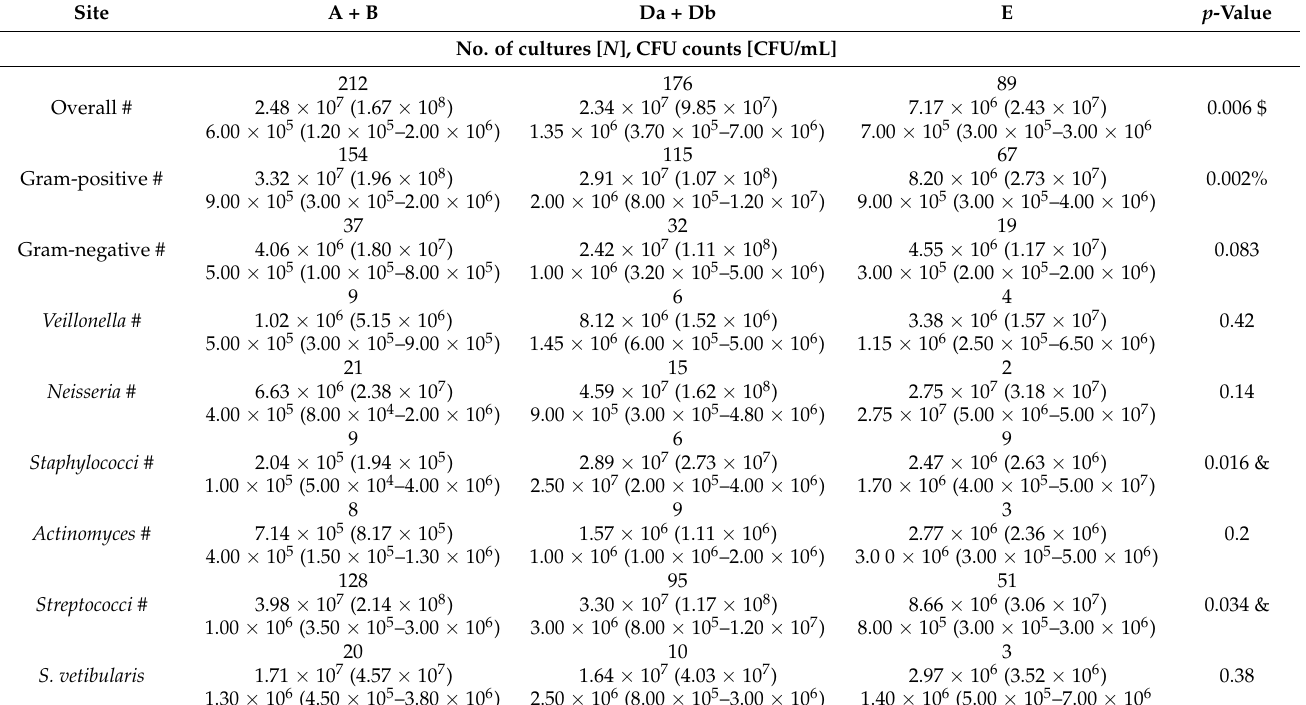
Table 3. Characteristics of sites after merging categories A + B and Da +